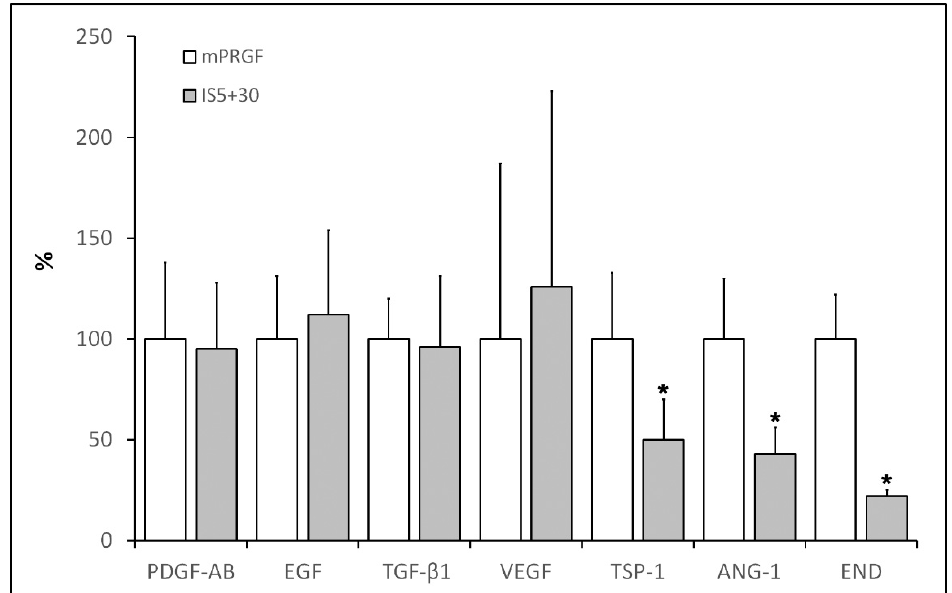
Figure 2. Percentage content of the different growth factors in the IS5+30 membrane with respect to the mPRGF evaluated in the study. Significant reduction (* p < 0.05) of TSP-1, ANG-1, and END levels was observed after heat treatment of the PRGF membrane (IS5+30) regarding the non-heated membrane (mPRGF).